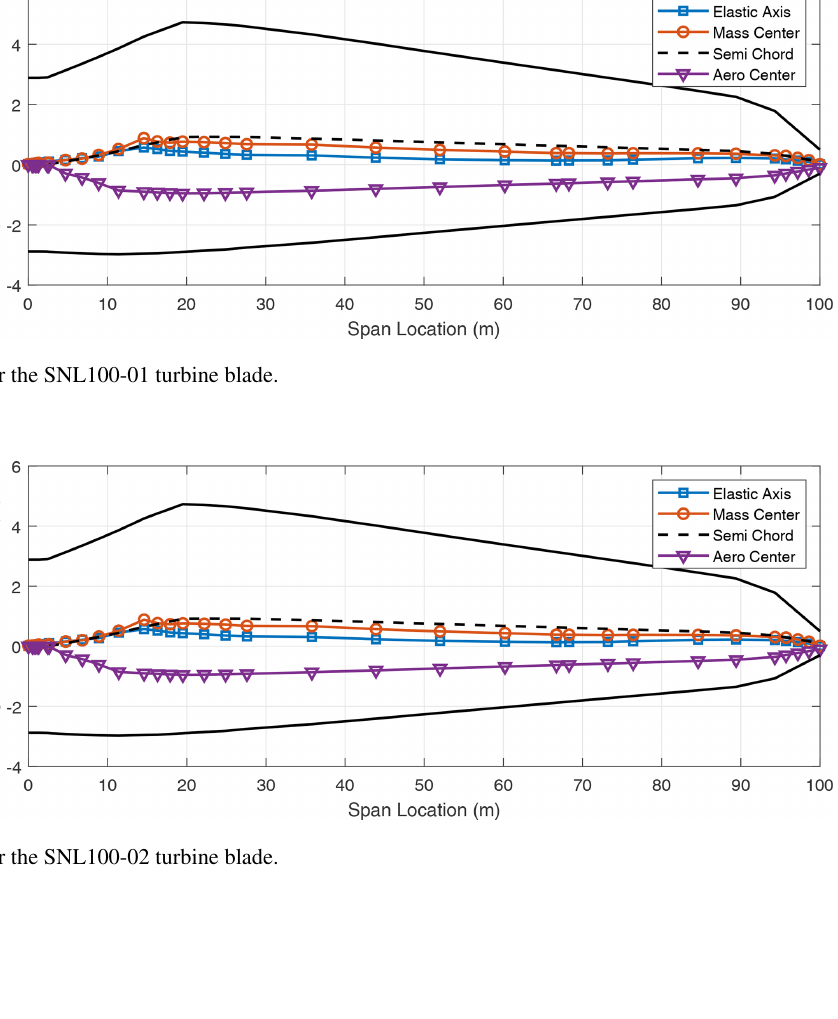
Wind Energ. Sci., 7, 1731–1751,